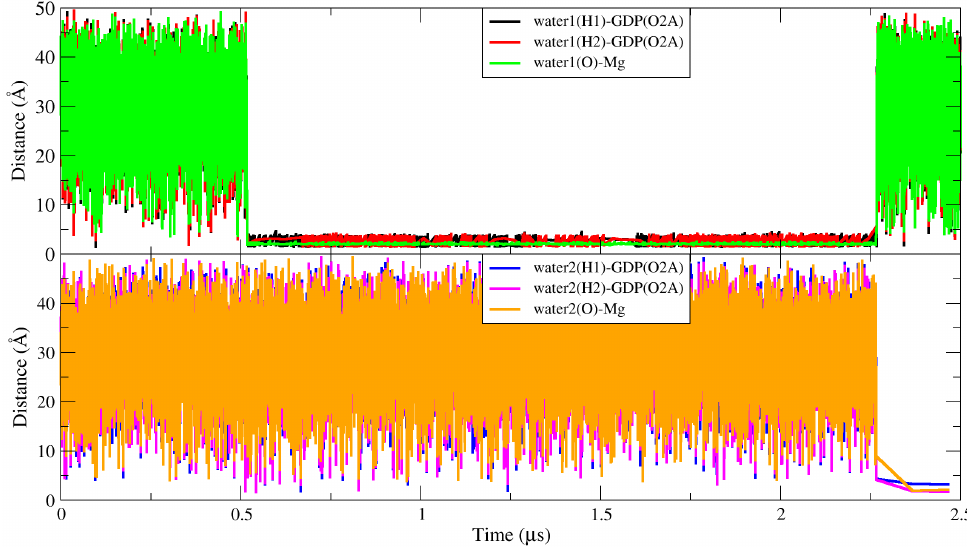
Figure A10. The dynamic change law of water molecules in the dynamic water pocket